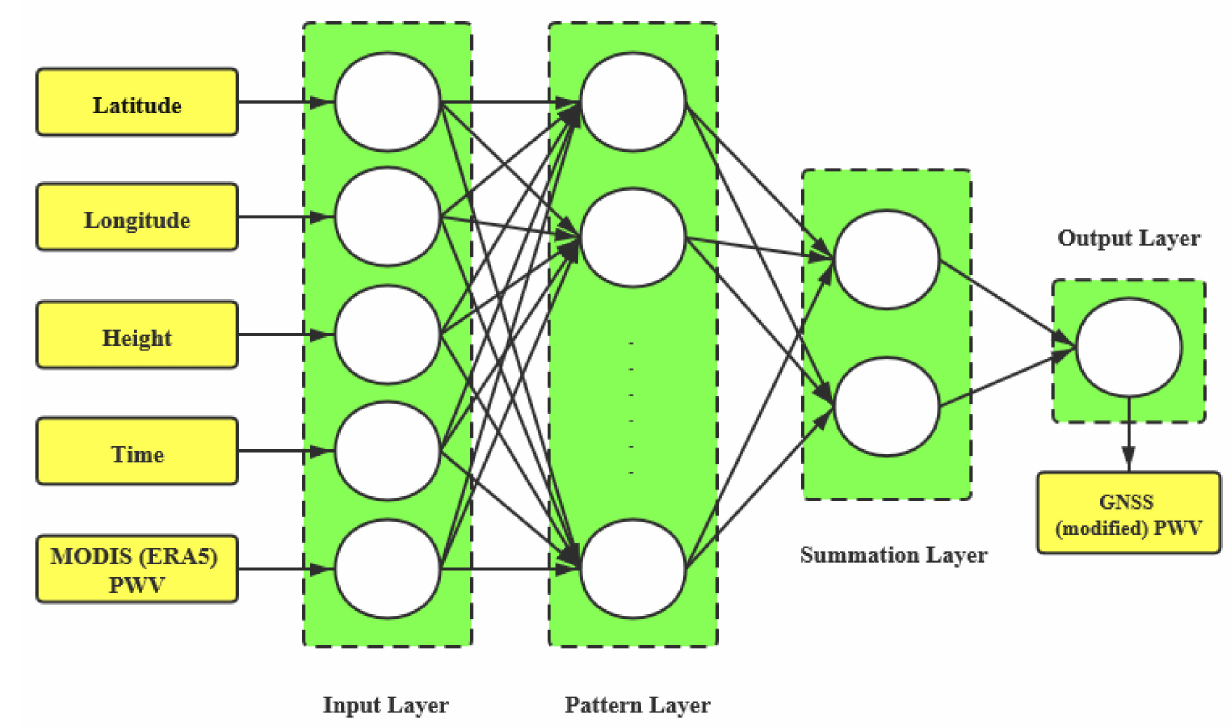
Figure 2. MODIS (ERA5)-GNSS PWV GRNN fusion